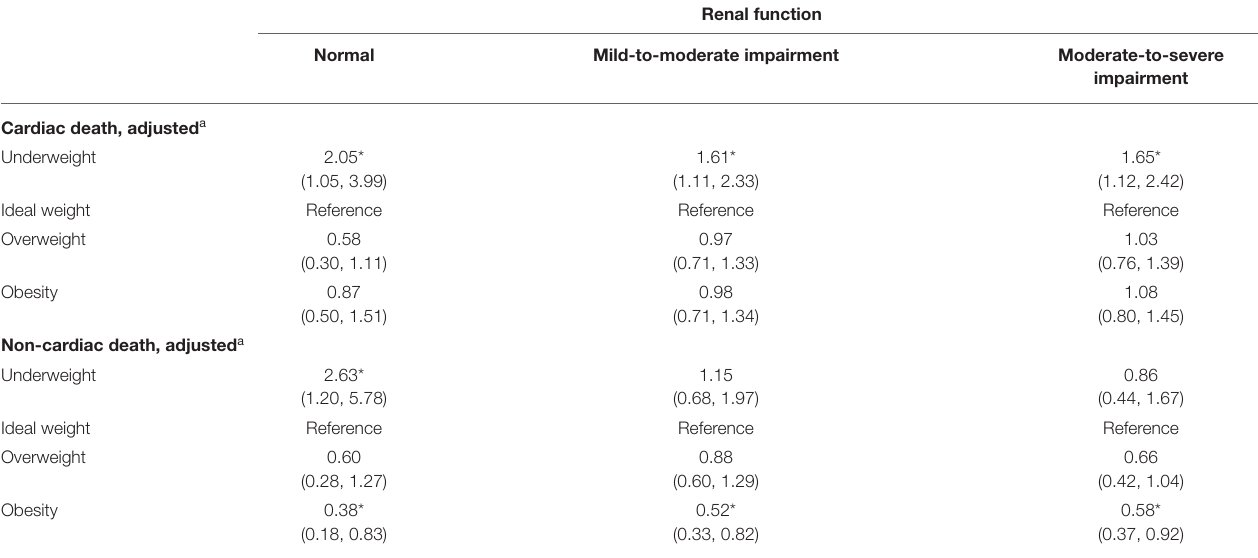
TABLE 3 | Competing risk of death from cardiac and non-cardiac cause by BMI groups based on renal function categories.